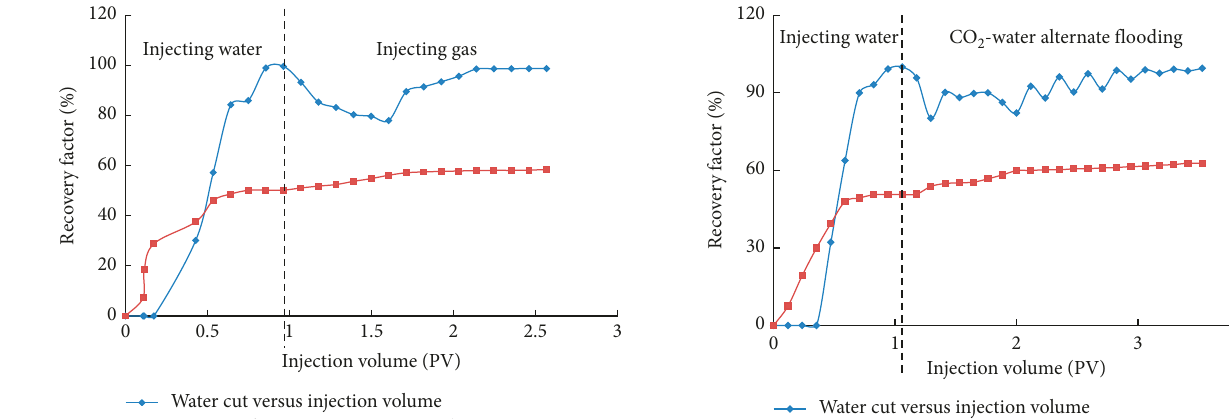
Figure 4: Curve of the recovery factor during continuous CO flooding after water flooding.